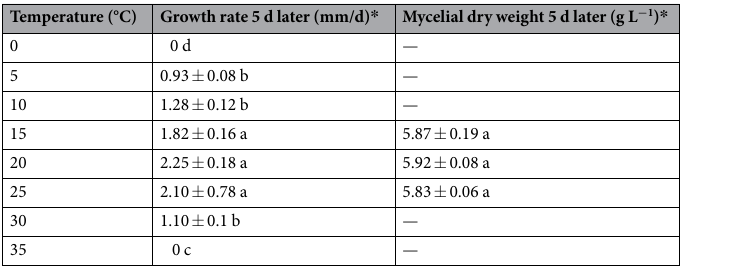
Table 5. Effect of temperature on the mycelial growth of Isaria farinosa . * Mean ± SE. Values followed by the same letters within a column do not differ significantly (ANOVA, P = 0.05). — No experiment to